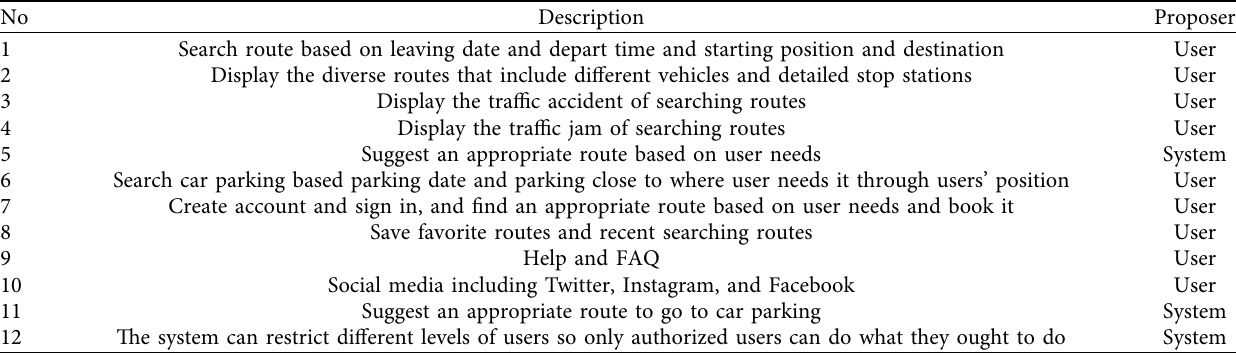
Table 3: Functional requirement.